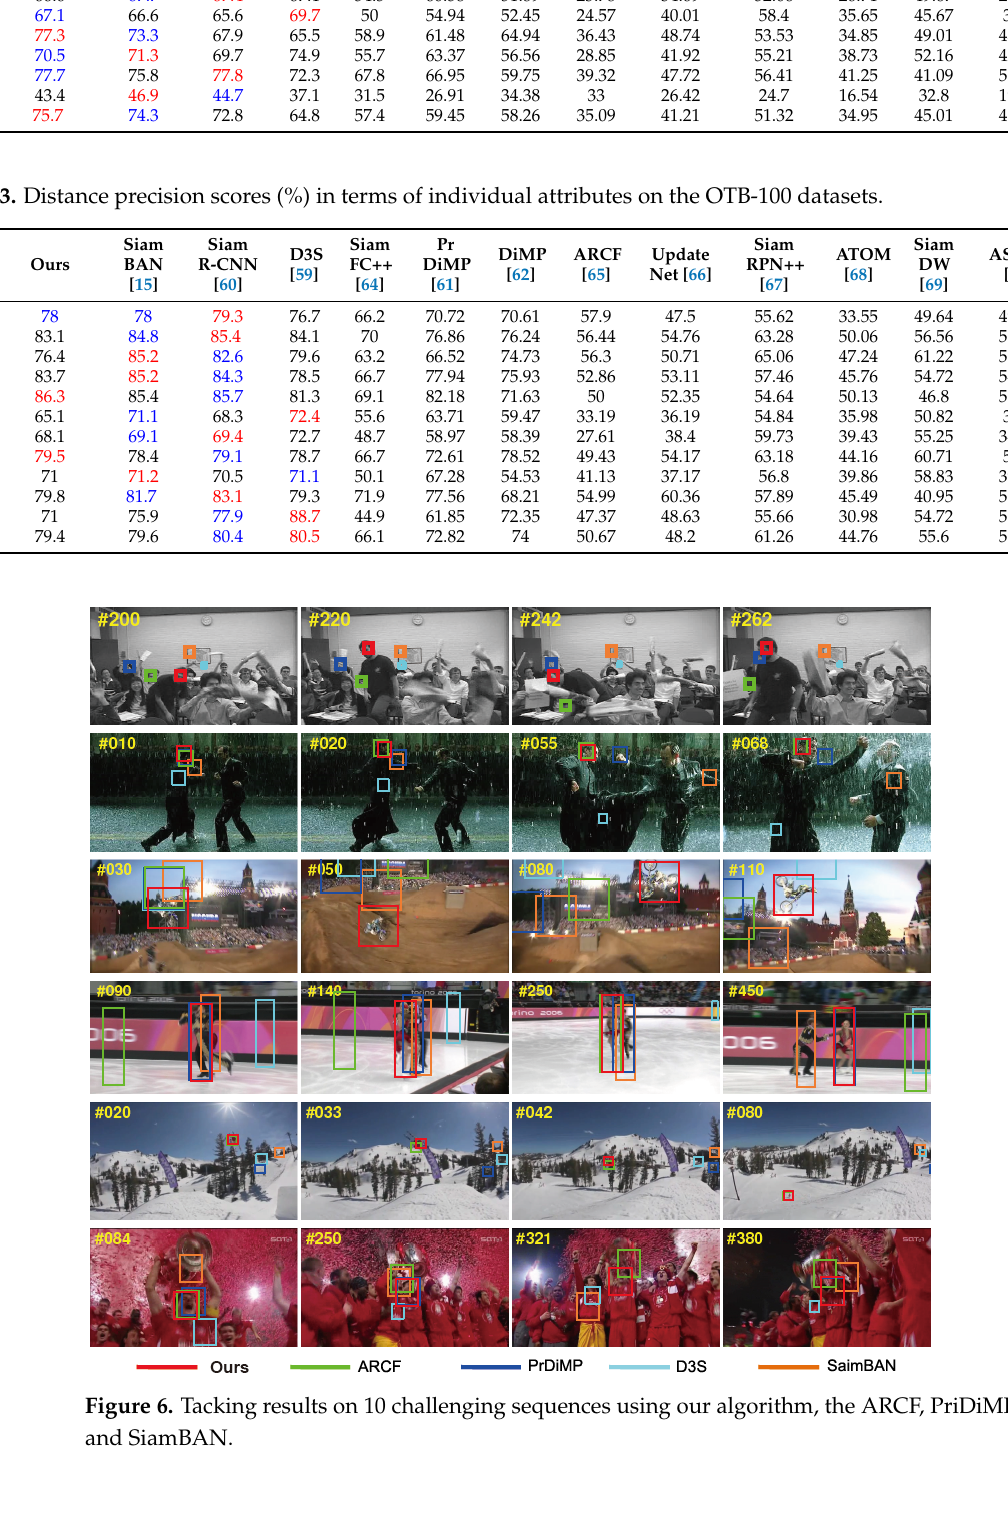
Illumination variation (23)